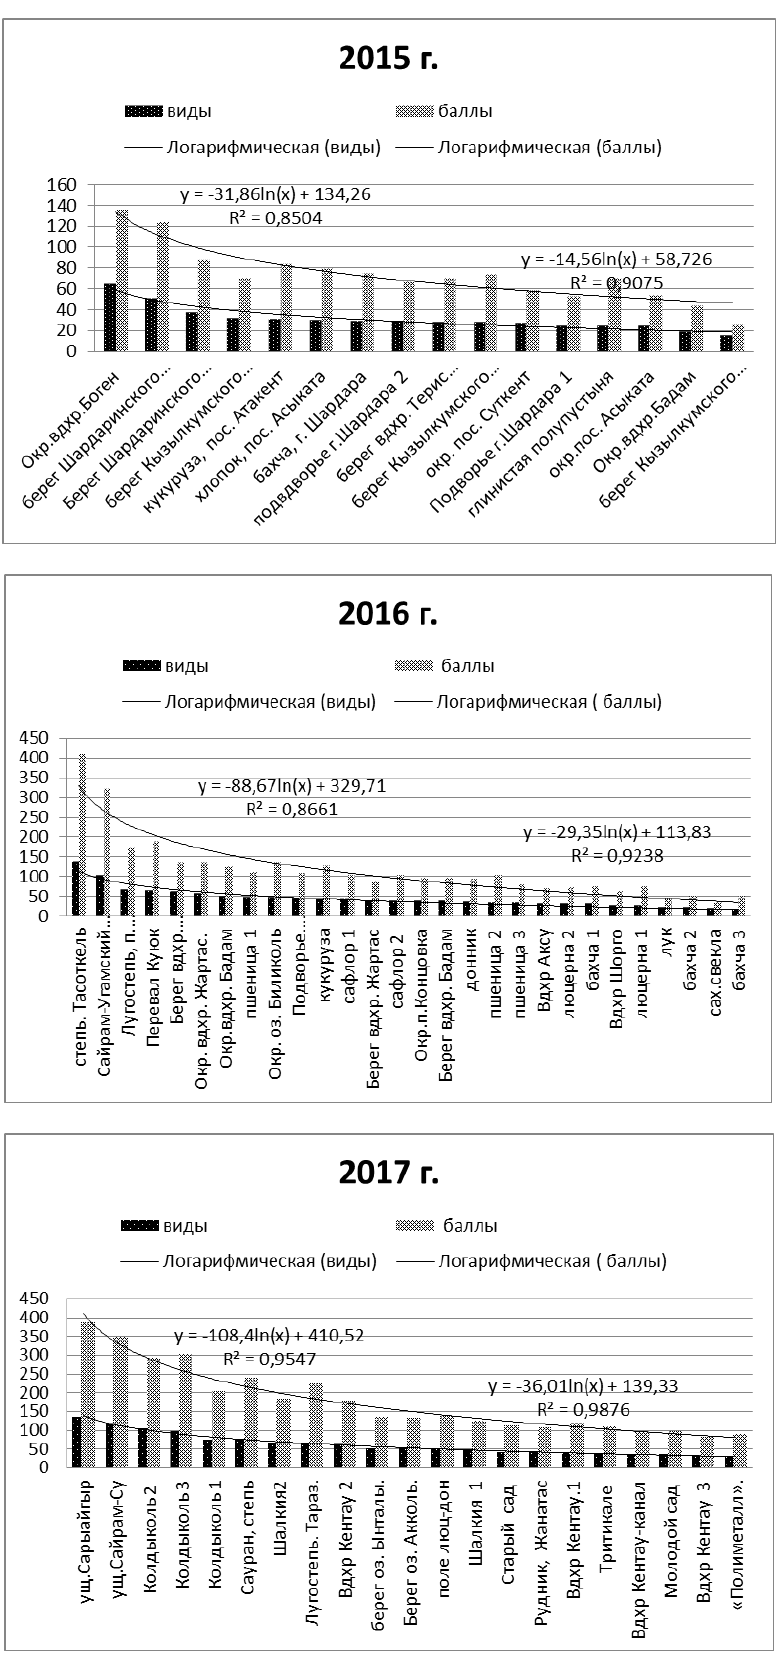
Рис. 2. Число индикаторных видов и их численность в баллах на исследованных территориях юга Казахстана с различной антропогенной